Question: What does this figure show? Answer in one sentence.
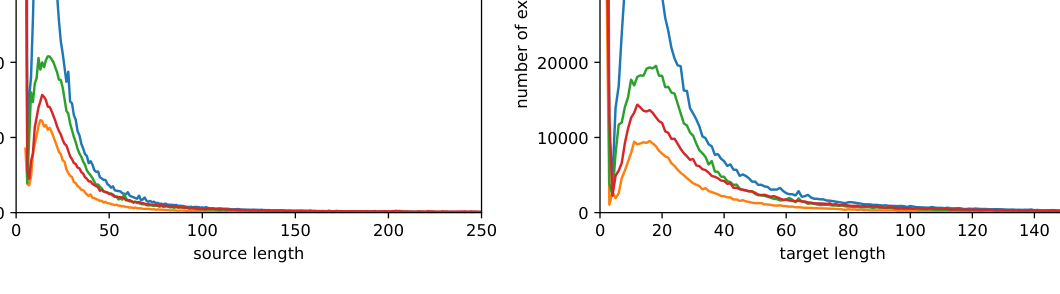
Answer: Distribution of training data instances by their token length.